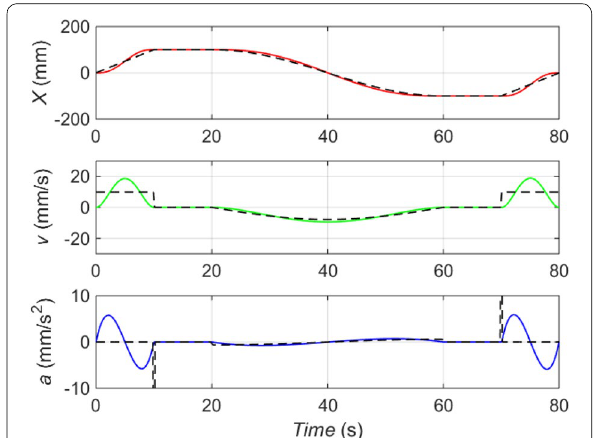
Figure 4 Position, velocity, and acceleration curves of fifth degree polynomial planning in the X